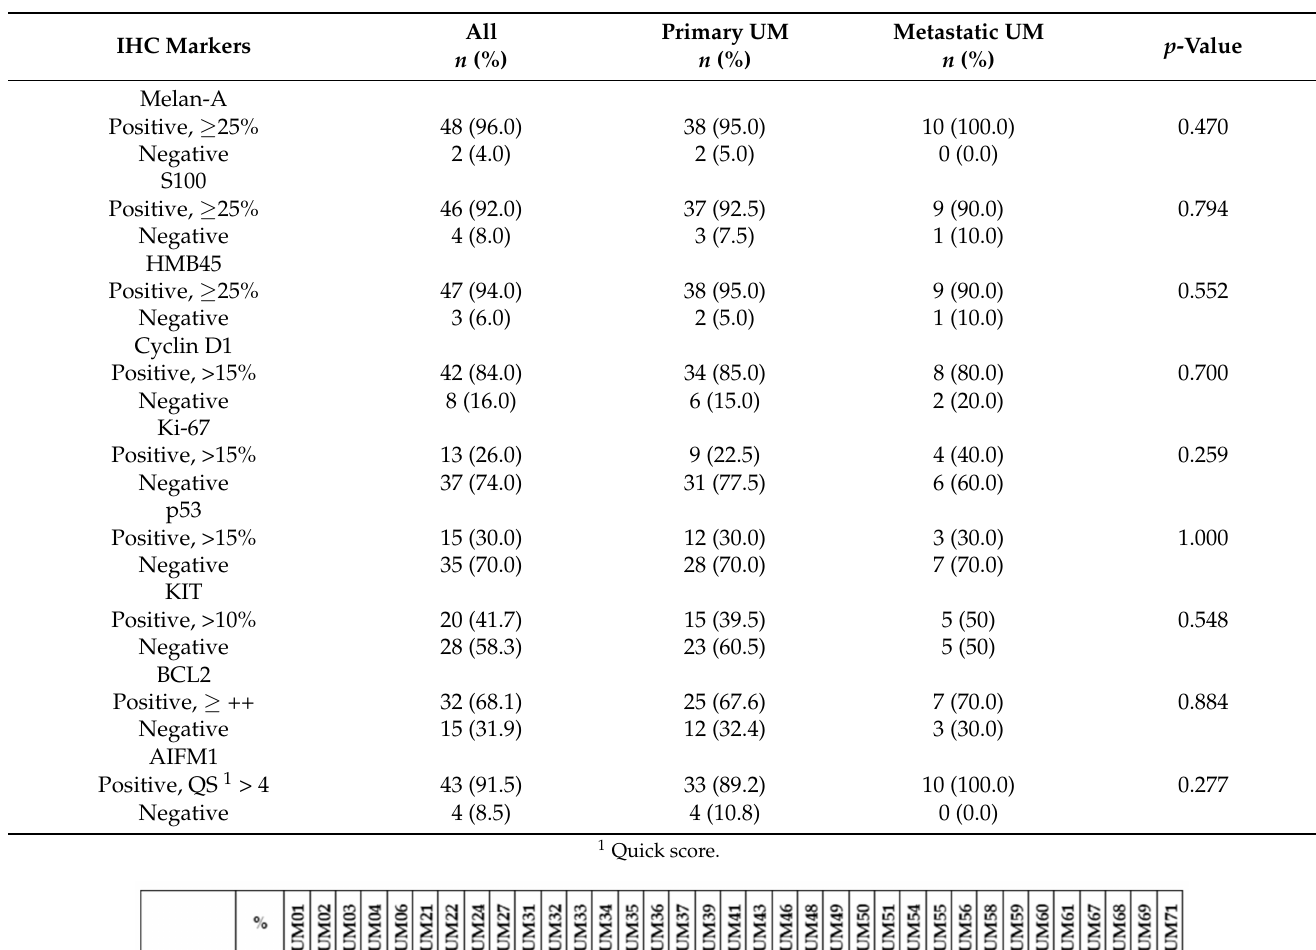
Table 2. Protein expression of studied IHC markers.